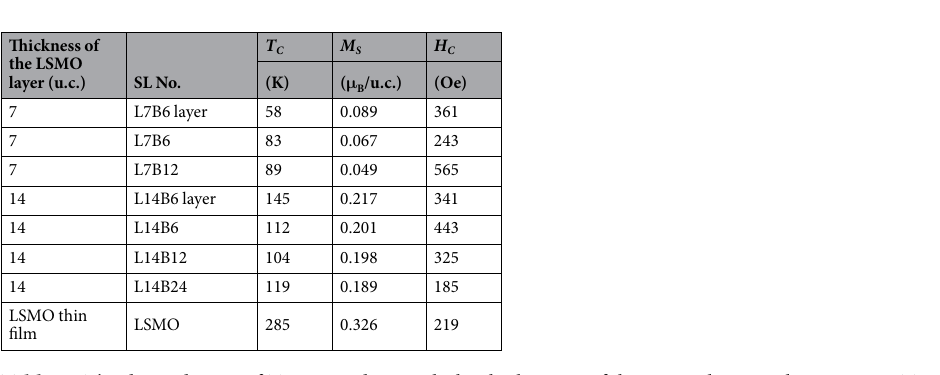
Table 1. The dependences of T C , M S , and H C with the thicknesses of the LSMO layer in the LSMO/BSTO